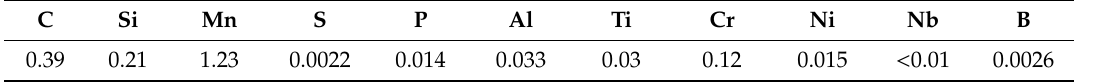
Table 1. Chemical composition of the material